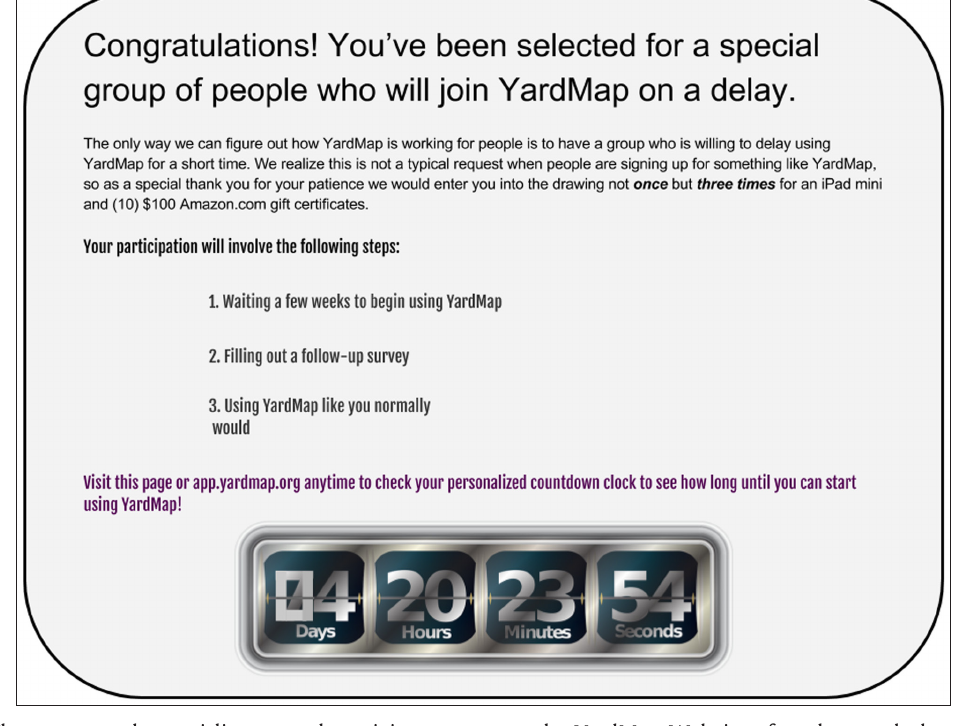
Figure 2: The message that waitlist control participants saw on the YardMap Website after they took the pre-test. This message remained when they signed in until they completed the post-test about 8 weeks